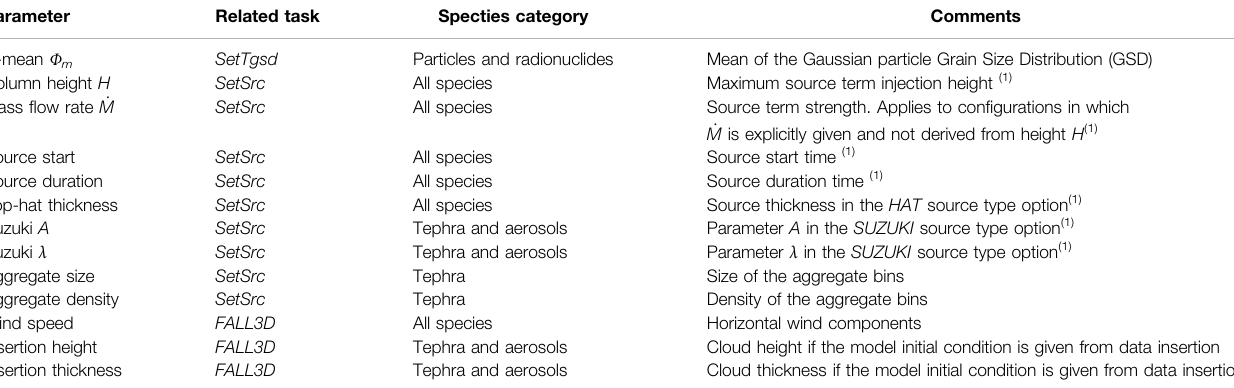
TABLE 1 | List of model input parameters that can be perturbed in FALL3D-8.1 to generate ensemble runs. The related task and the species category affected are also indicated (see Folch et al. (2020), for details).